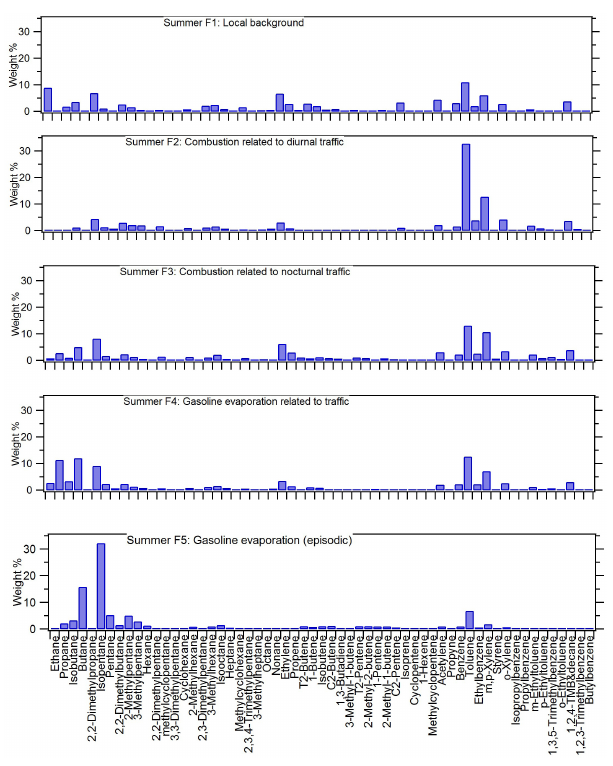
Figure 7. Source composition profiles (relative abundance of spe- cific compounds within each factor in wt%) in summer 2011.